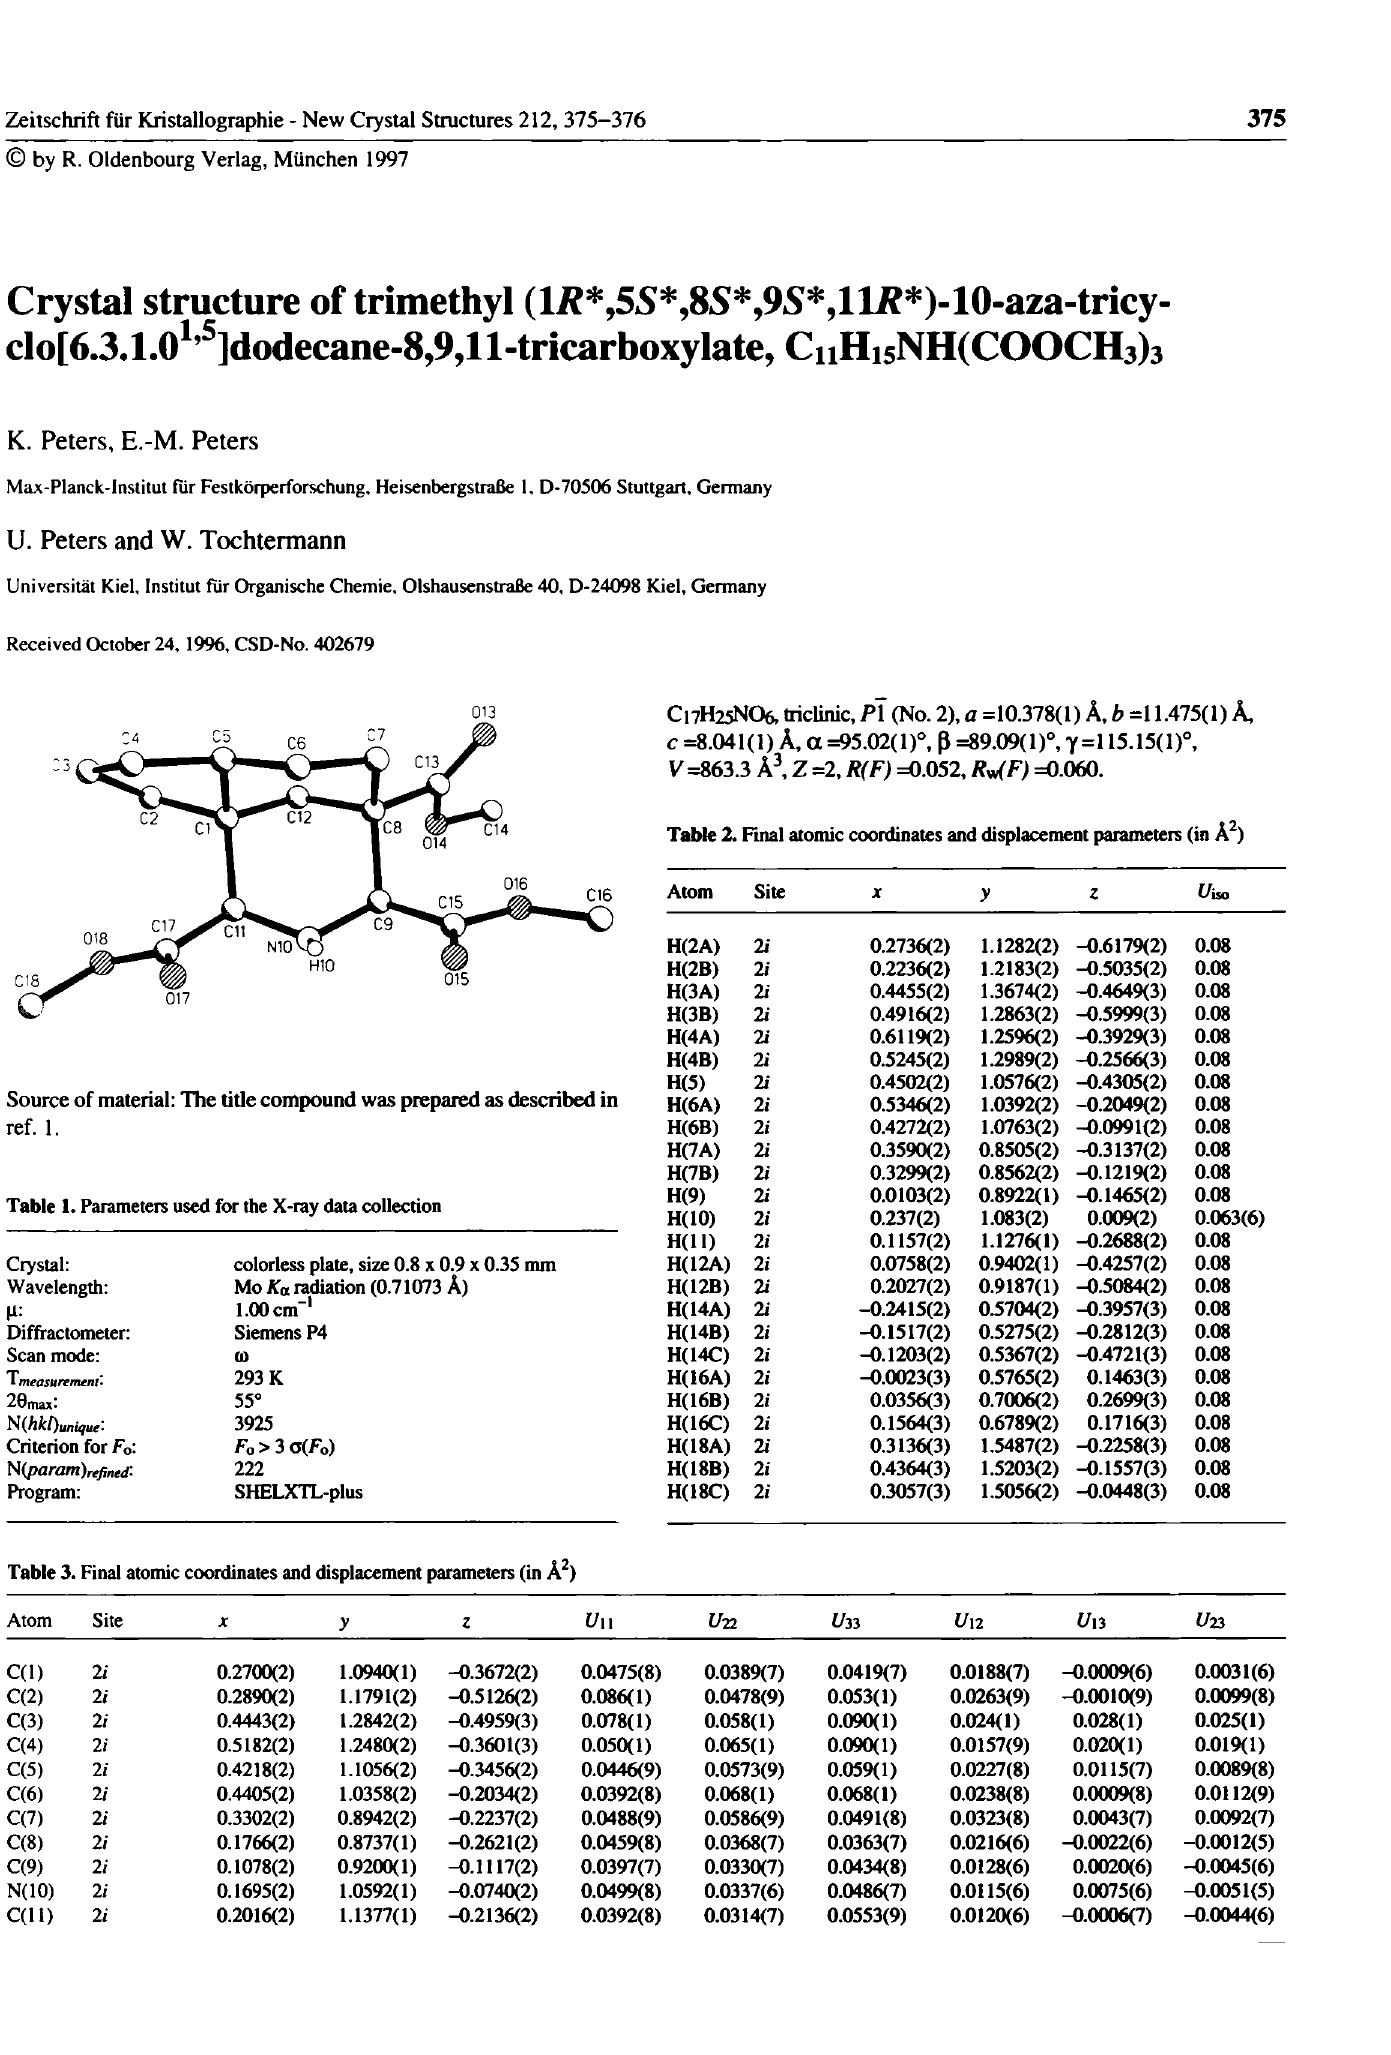
Table 3. Final atomic coordinates and displacement parameters (in Â 2 ) Atom